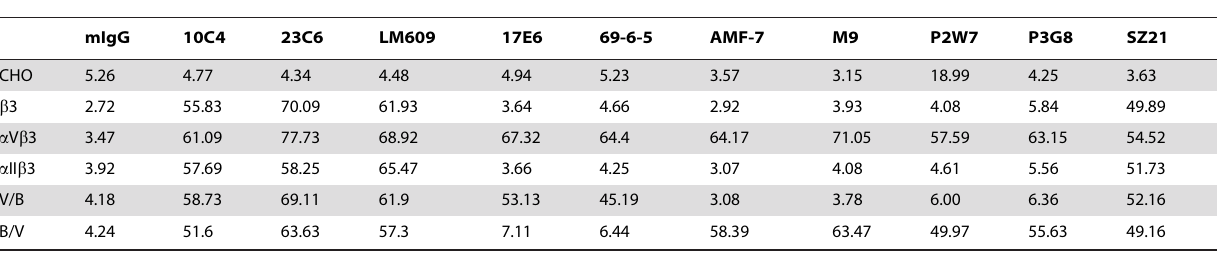
Table 1. MAb binding to cells expressing tail-swapping chimeras.